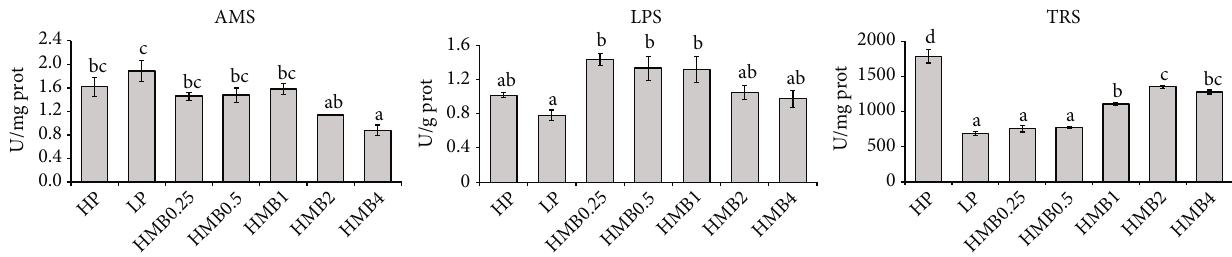
Figure 1: The activities of digestive enzymes in intestine of kuruma shrimp fed with the experimental diets. Values are expressed as the means ± SE ( n = 3 ). Di ff erent lowercase letters above the bars present signi fi cant di ff erences ( p < 0 : 05 ). AMS: α -amylase; LPS: lipase; TRS: trypsin.